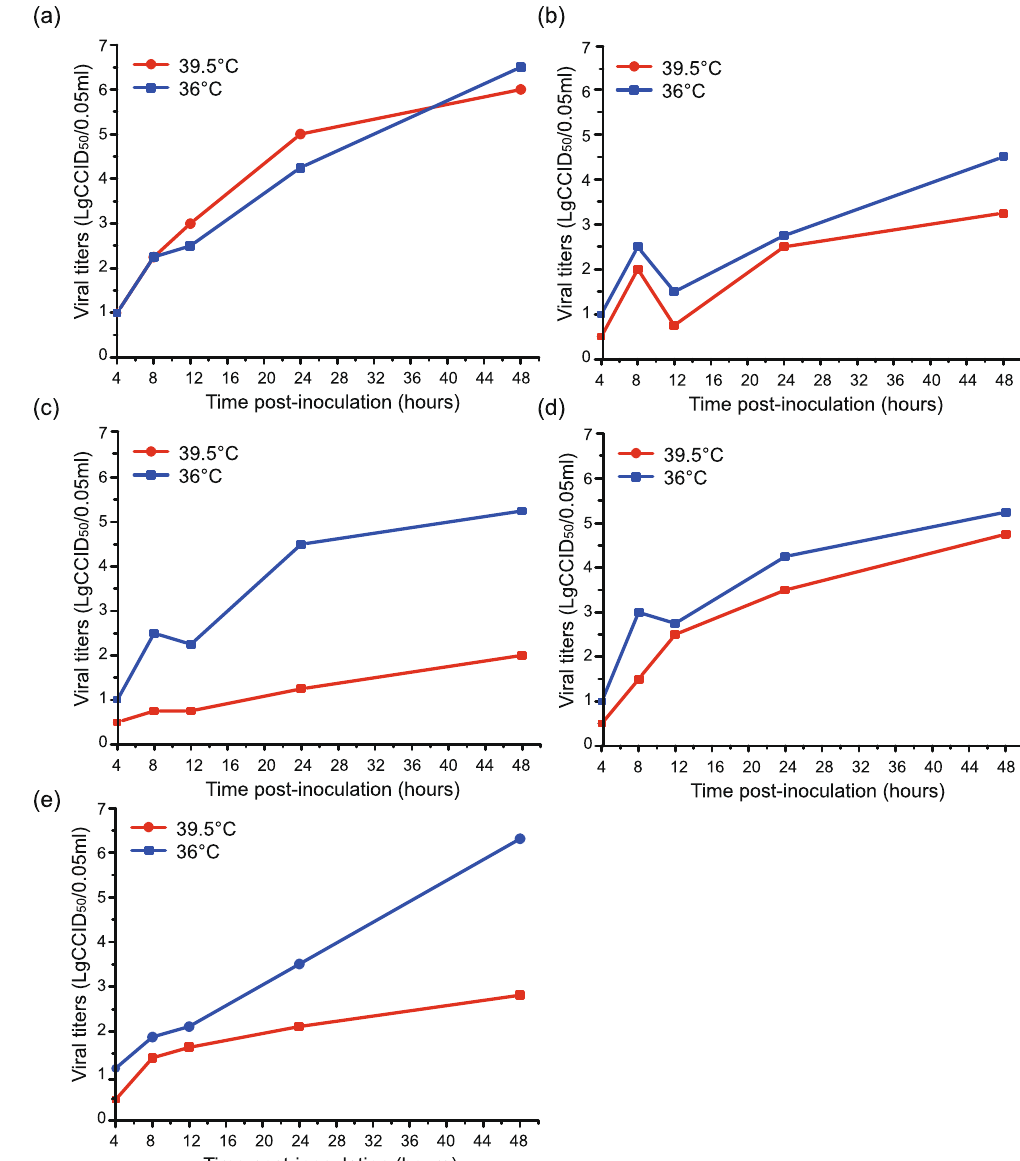
Figure 4. The viral titers of five EV-A90 strains in different time were drawn in the coordinate system. The blue line represented the growth curve in 36 °C and the red one represented the growth curve in 39.5